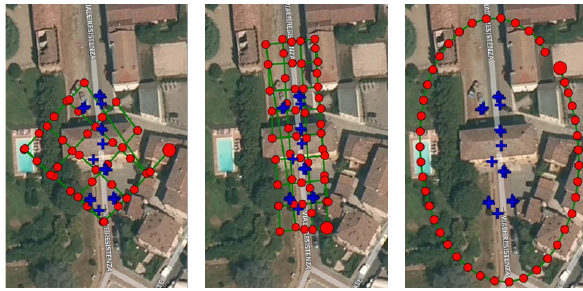
flight has been made with a double grid plan and an almost square geometry, with the diagonal oriented as the tunnel axis (named square flight), the second flight was made with a double grid plan and a rectangular geometry, with the same orientation of the tun- nel (named rectangular flight) and the third flight was made with a circular plan, with the camera tilted towards the center where the tunnel is located (named circular flight). Figure 3 gives an overview of the different flight plans.